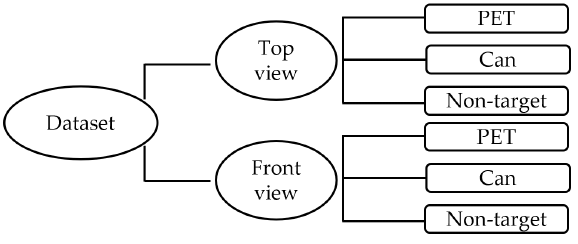
Figure 3. Dataset and its